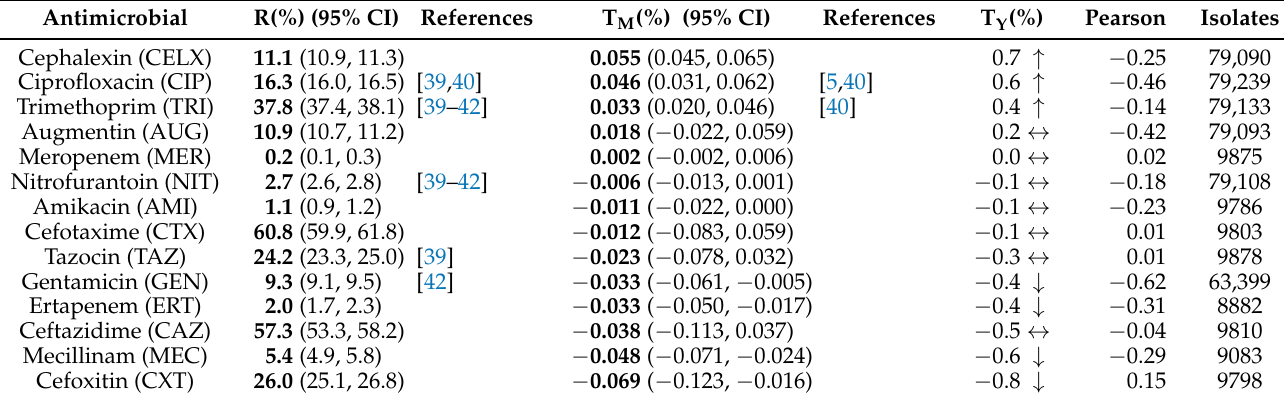
Table 2. AMR summary for E. coli in urine samples.